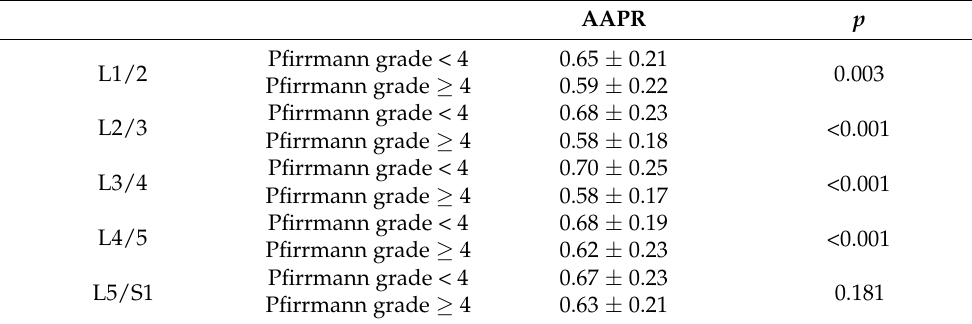
Values are expressed as n (%). Table 3. The relationship between the severity of individual disc degeneration and